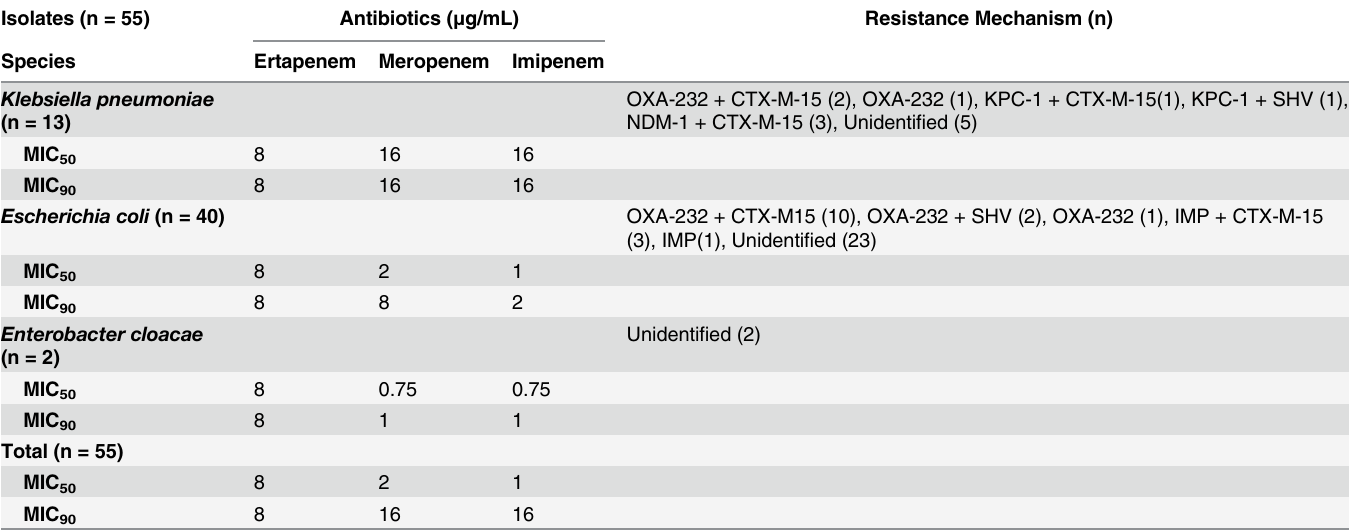
MIC, minimum inhibitory concentration; MIC 50 , minimum inhibitory concentration for 50% of the given species; MIC 90 , minimum inhibitory concentration for 90% of the given